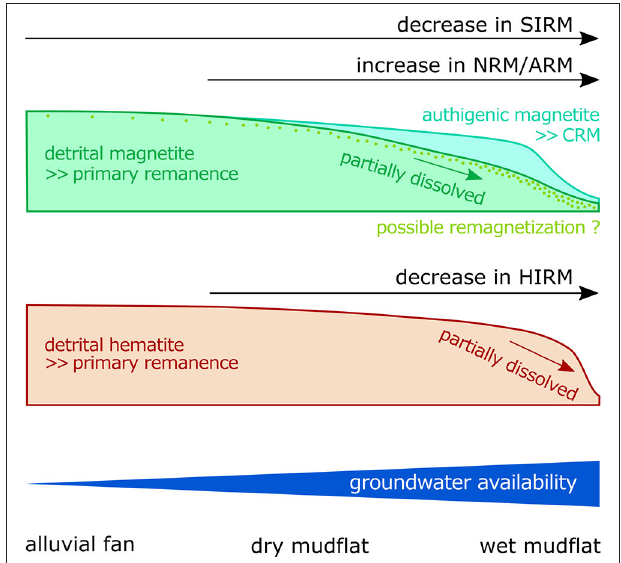
FIGURE 10 | Principle sketch of the interpreted magnetic alteration scenario of the ferro(i)magnetic phases, comprising dissolution and neo-formation of magnetite and dissolution of hematite, causing secondary chemical remanent magnetization (CRM) of authigenic magnetite and possibly also partial remagnetization of the detrital